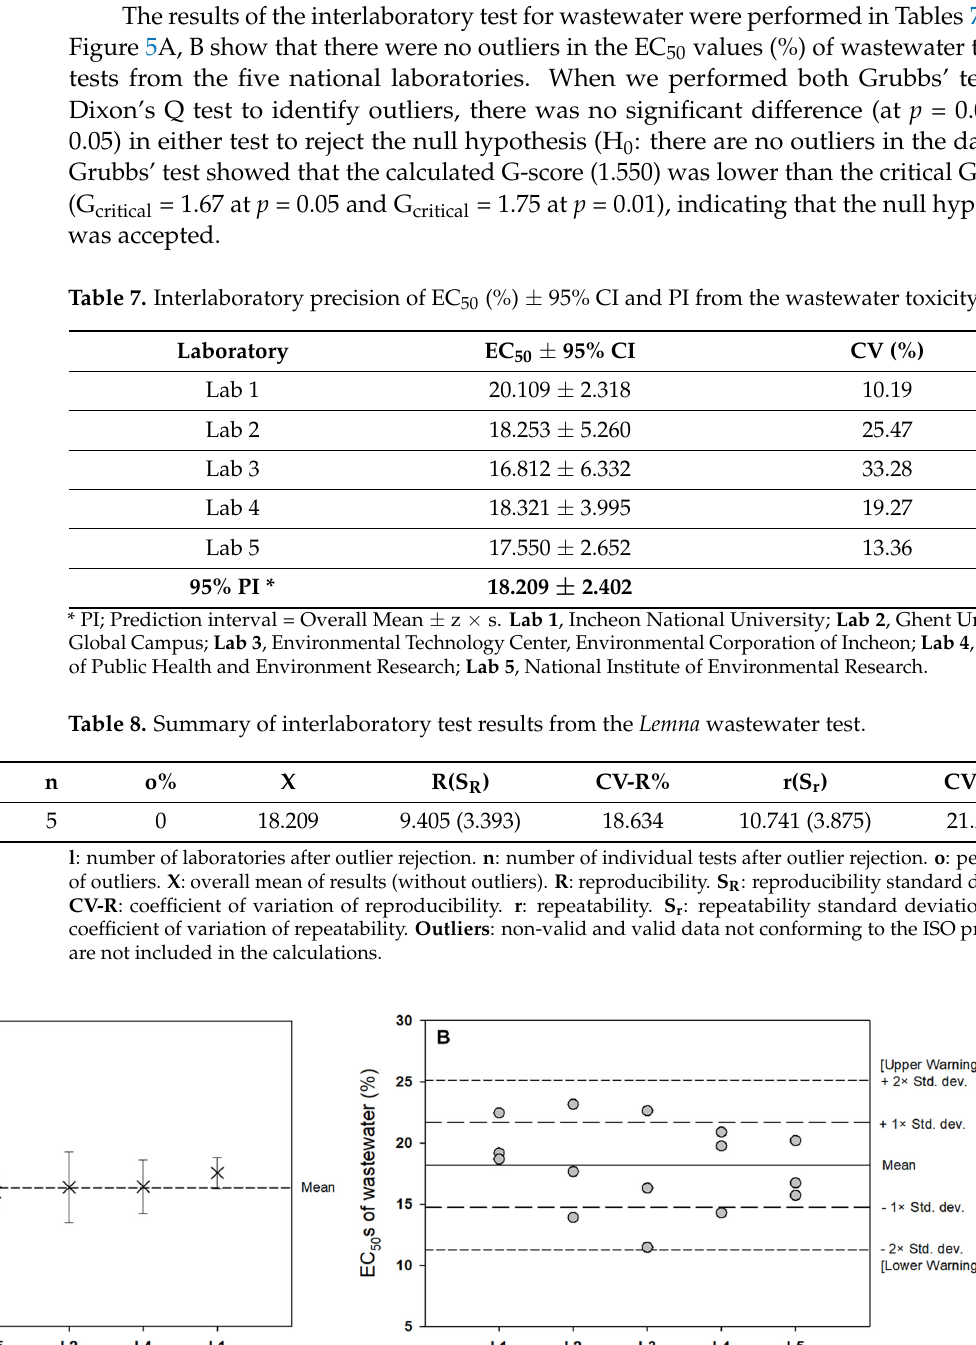
Table 7. Interlaboratory precision of EC 50 (%) ± 95% CI and PI from the wastewater toxicity test.